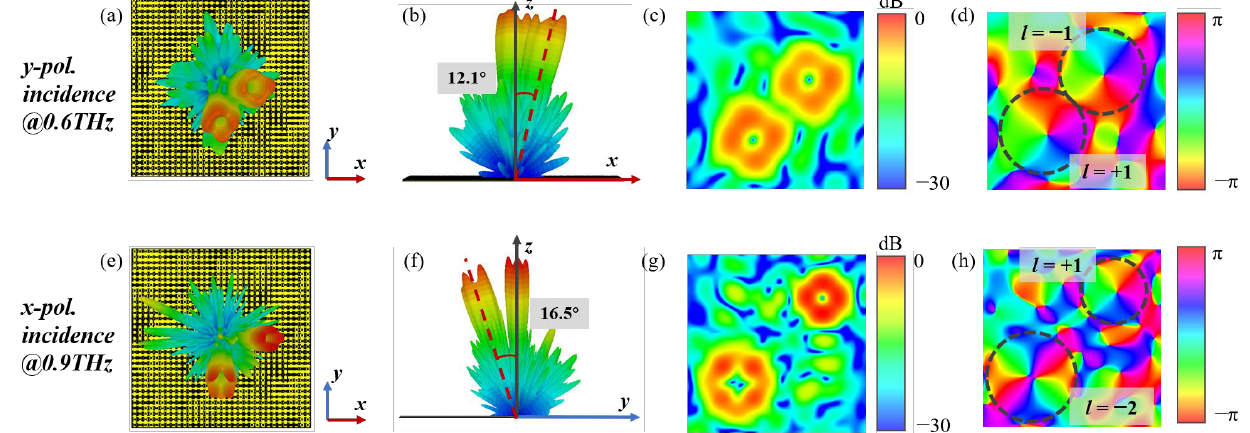
Figure 6. Full-wave simulated scattering field diagrams of the multiple vortex beams metasurface. ( a ) Top view and ( b ) side view of the 3D far-field simulation scattering diagrams; ( c ) magnitude and ( d ) phase of the 2D far-field partial diagrams of the l 1 = + 1 and l 2 = − 1 deflected vortex beams at 0.6 THz under the y -polarized incidence. ( e ) Top view and ( f ) side view of the 3D far-field simulation scattering diagrams; ( g ) magnitude and ( h ) phase of the 2D far-field partial diagrams of the l 3 = + 1 and l 4 = − 2 deflected vortex beams at 0.9 THz under the x -polarized